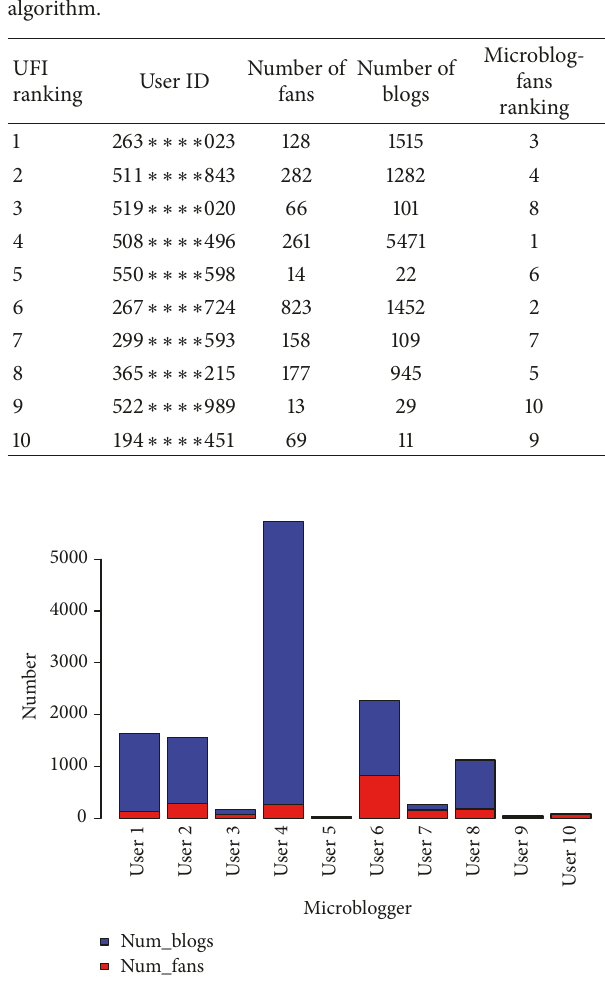
Figure 5: The overall ranking via the microblog-fans ranking algo-